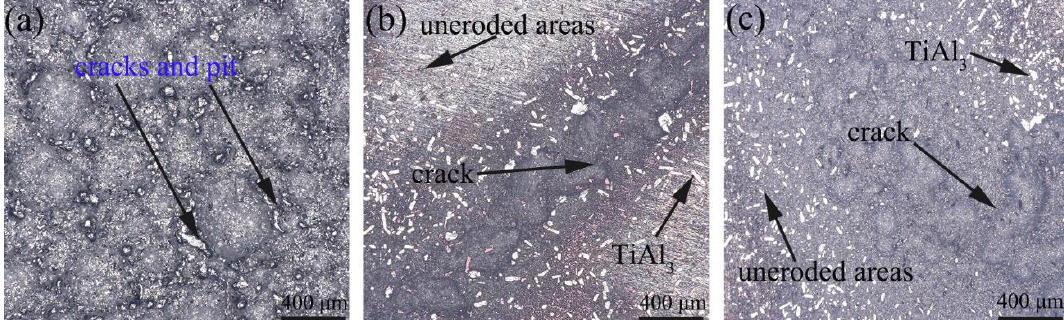
Figure 4. Metallurgical structure images of Al, Al–5Ti, and Al–10Ti samples after cavitation erosion for 60 min in 3.5 wt.% NaCl solution; ( a ) Al; ( b ) Al-5Ti; ( c ) Al-10Ti.